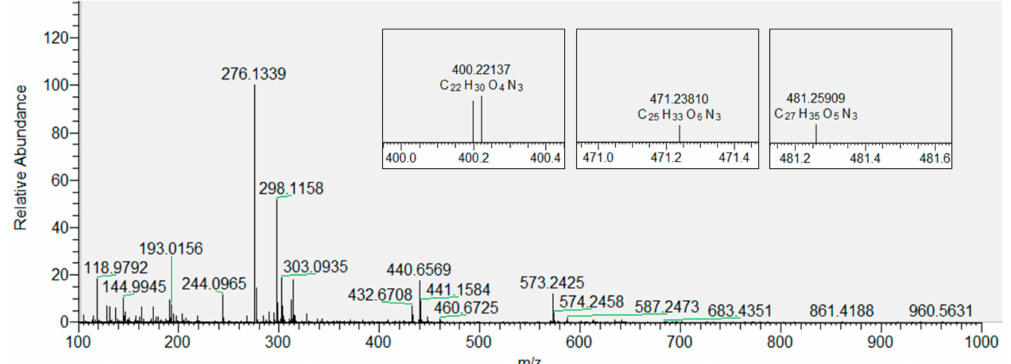
Figure 4. Mass spectrum of LPP ions of DOPC with zoomed-in regions corresponding to the molecular ions of three derivatized products: hydroxy-octenal (left), hydroxy-oxo-undecenoic acid (middle), and oxo-tridecadienoic acid